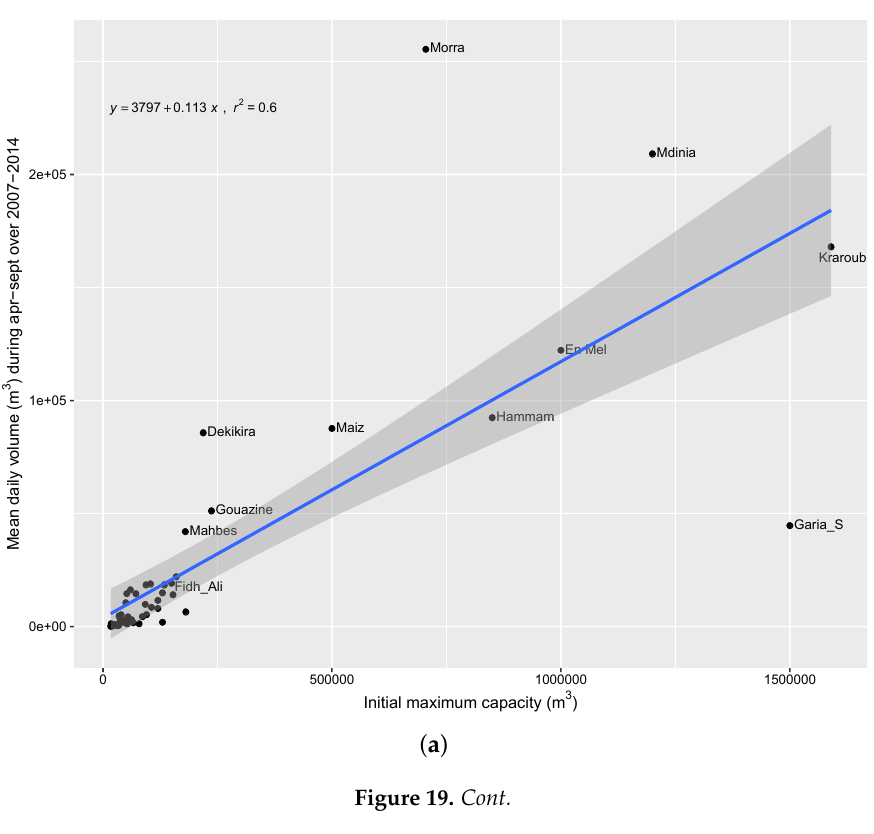
Figure 18. Number of drought days per lake (here, drought refers to days below 5000 m 3 over the dry season). Pale red refers to results with silting, while dark red represents a best case scenario without silting.